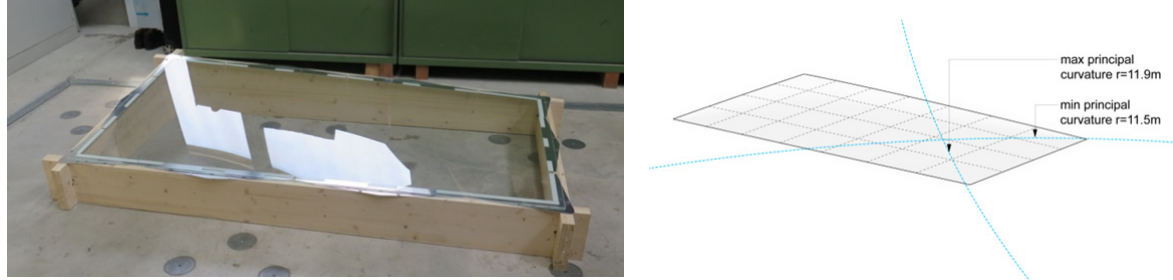
Fig. 7 Ruled-surface